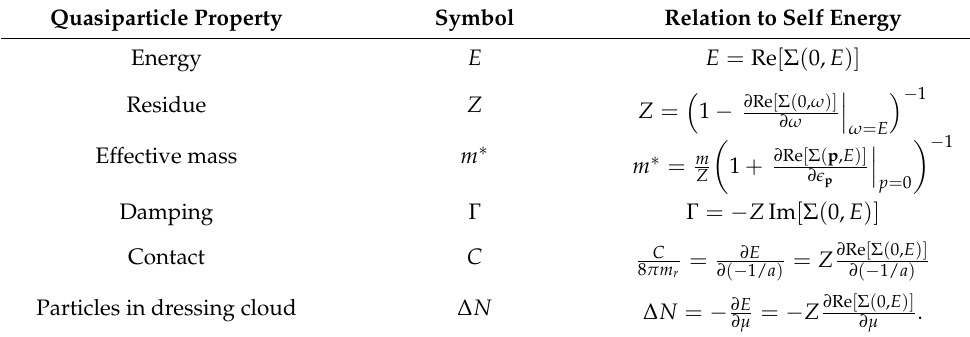
Table 1. Quasiparticle properties of an impurity in a medium. The quasiparticle energy E is found as the solution of a transcendental equation, and serves as an input into the remaining expressions. The expressions for m ∗ , C and ∆ N involve Z since, for a general parameter λ , one has ∂ λ E = ∂ λ Re [ Σ ( 0, E )] + ∂ E Re [ Σ ( 0, E )] ∂ λ E , so that ∂ λ E = Z ∂ λ Re [ Σ ( 0, E )] . Quasiparticle